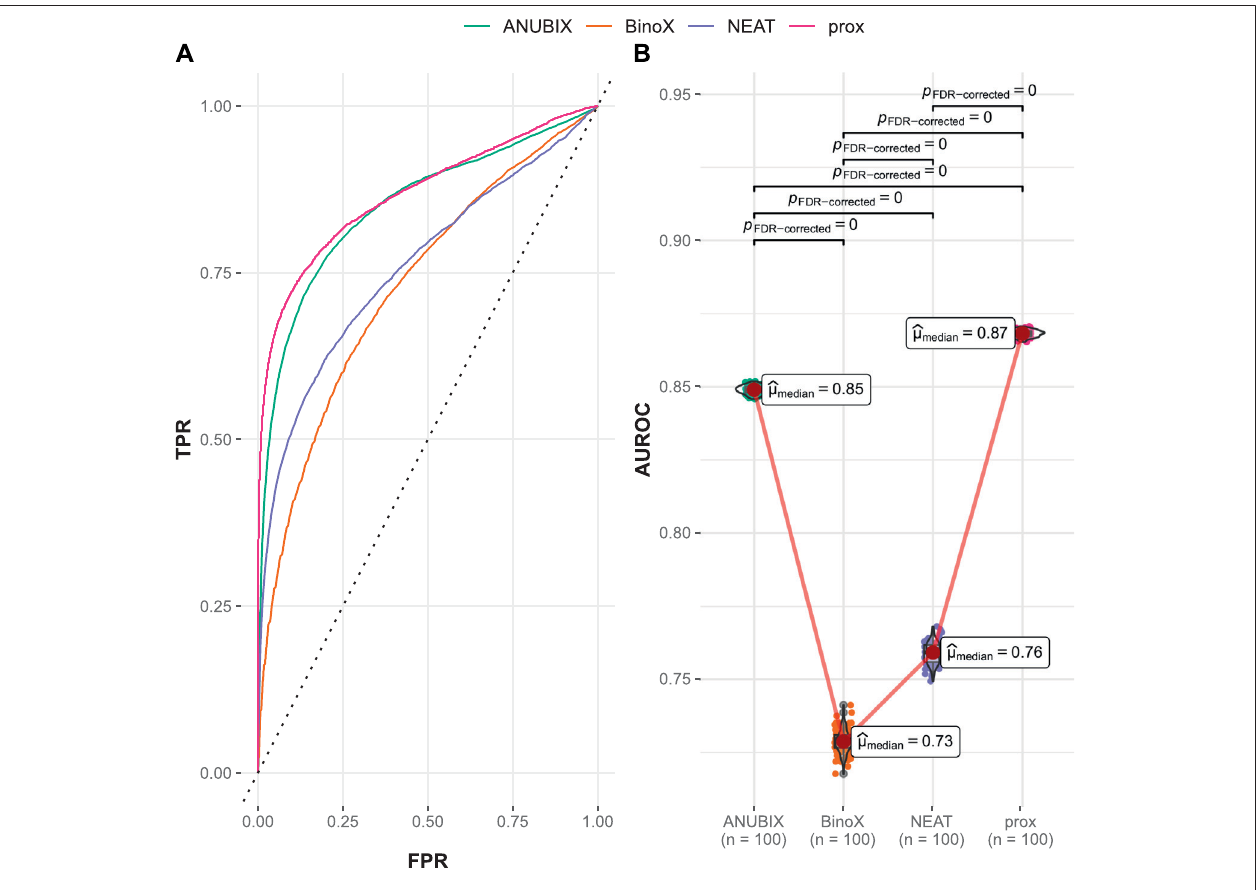
FIGURE5| Drug – disease association – basedperformanceontheFCbench.Performanceofthedifferentdrugrepurposingtools: ANUBIX(green),BinoX (orange), NEAT (purple), and proximity (prox, pink) on (A) ROC curves, where the dotted line represents random prediction, and (B) AUROC using sampled sets from the benchmarkcontainingequal numbers ofpositive and negative drug – disease combinations. The pairwise Wilcoxon ranksum test wasused toassess thesigni fi cance of difference on AUROC. FDR-corrected p -values were obtained using the Benjamini – Hochberg procedure.